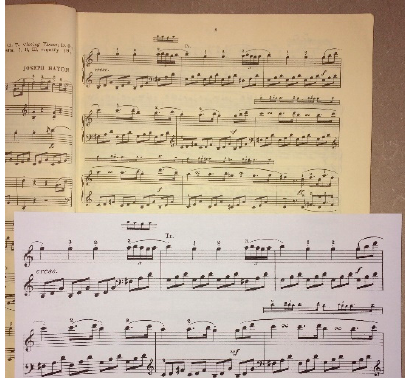
Figure 10. Music can be enlarged on a standard copier.